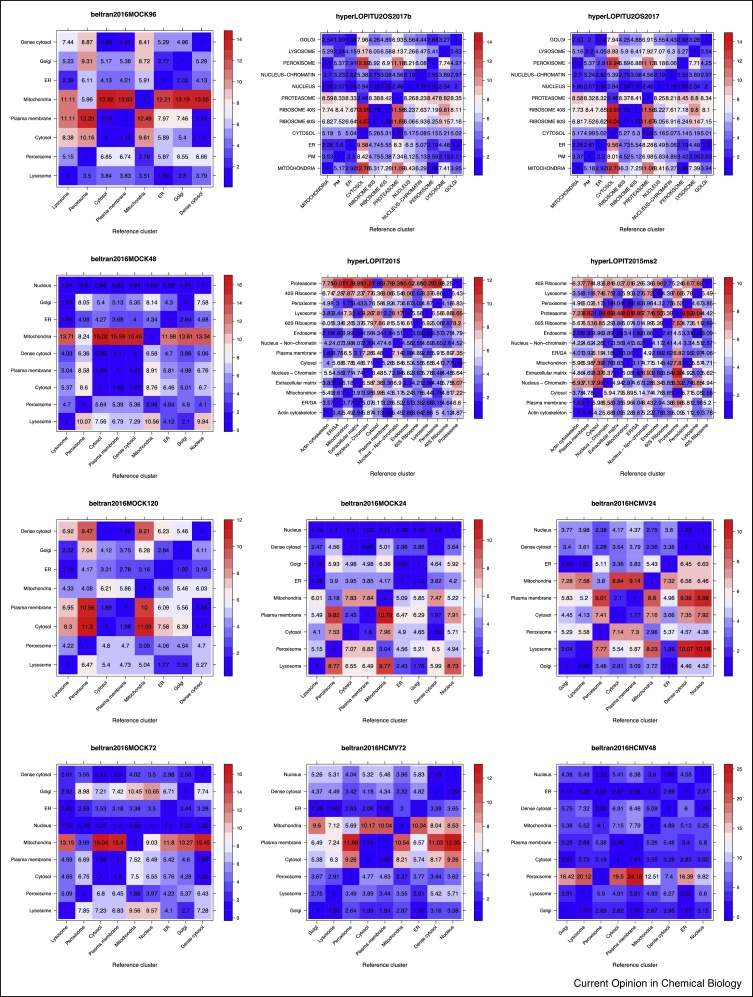
Quantitative separation heatmaps for the 29 experiments used in this study. The experiments are ordered according to the median average between cluster distance (see Figure 8).